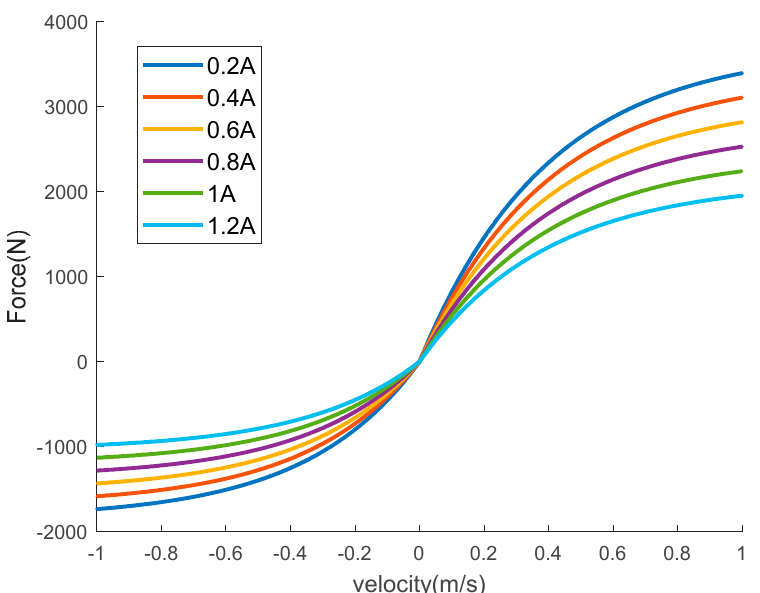
Figure 3. The force-velocity characteristics of controllable damper. Table 2. Parameters of quarter HM-EV